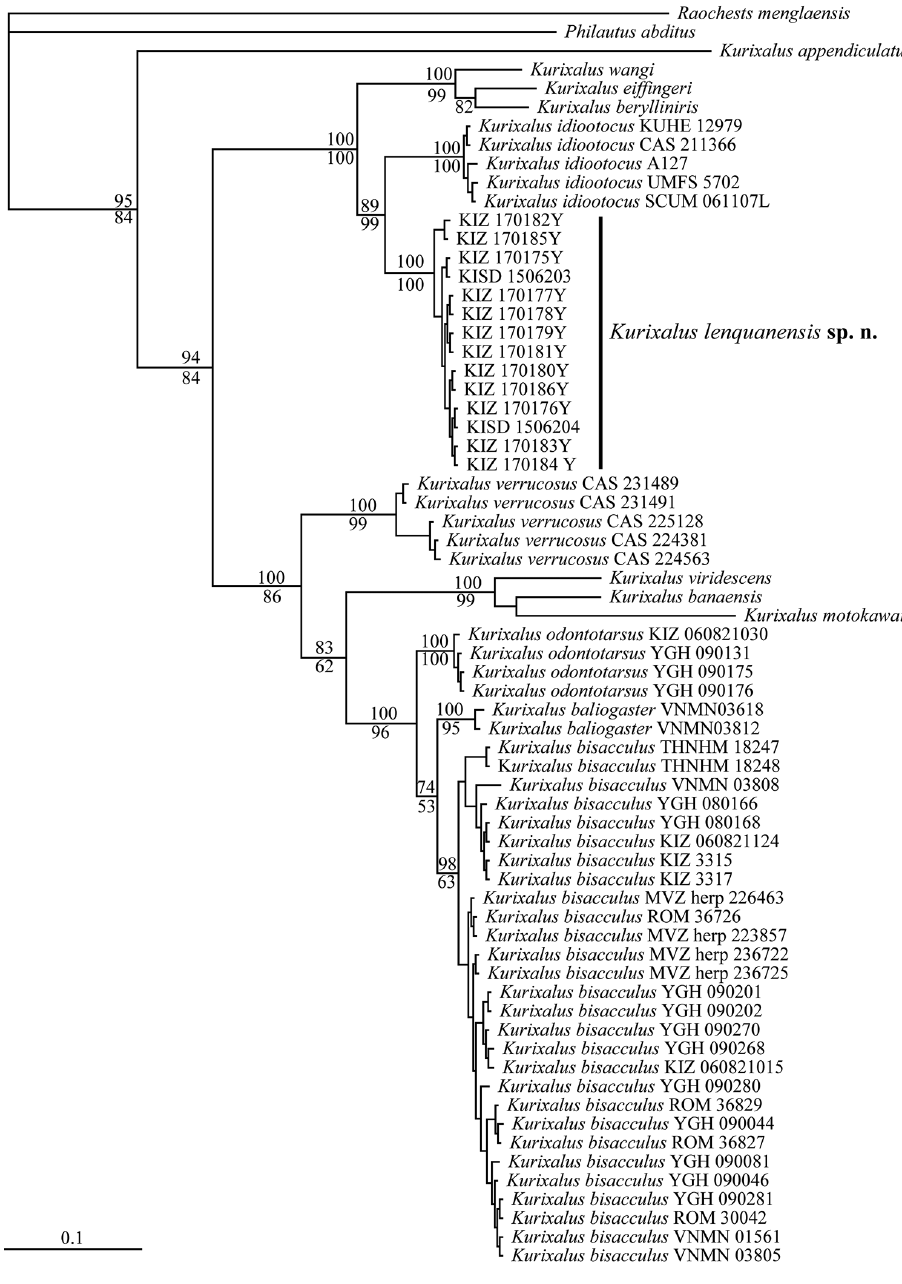
Figure 2. Bayesian phylogram of Kurixalus inferred from 870 bp of 16S rRNA gene. Numbers above and below branches are Bayesian posterior probabilities (BPP) and ML bootstrap values (only values above 50% are shown),